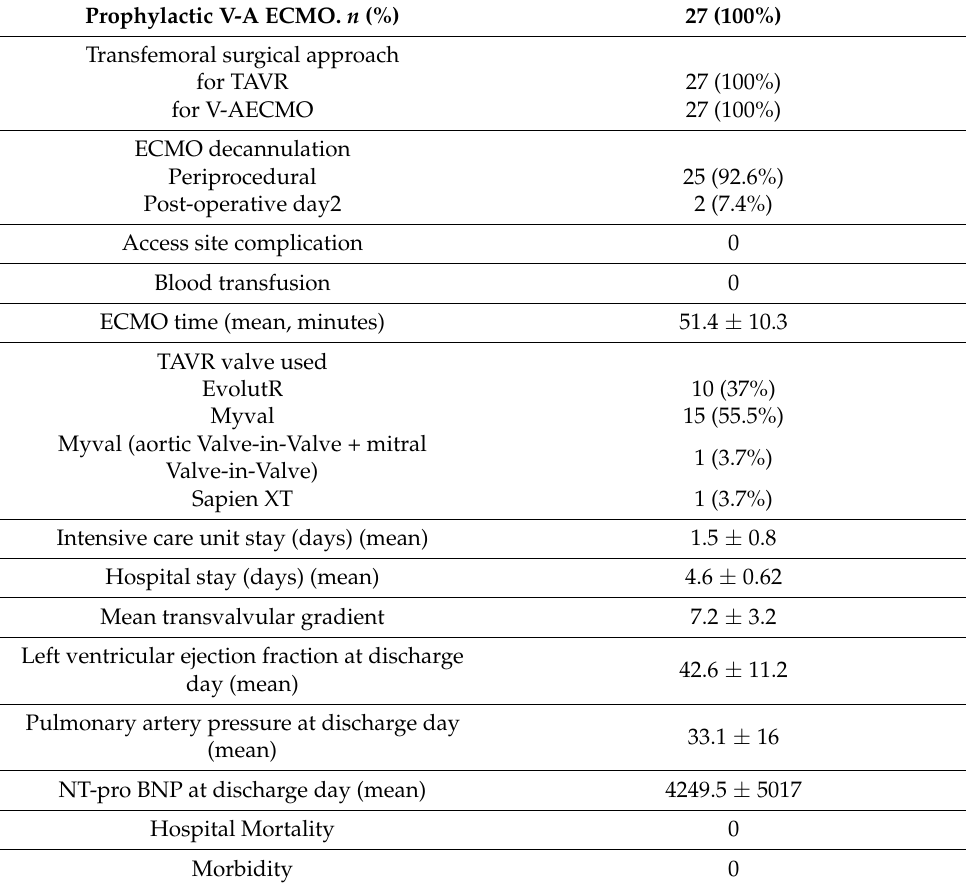
Table 2. Prophylactic V-A ECMO characteristics and clinical course